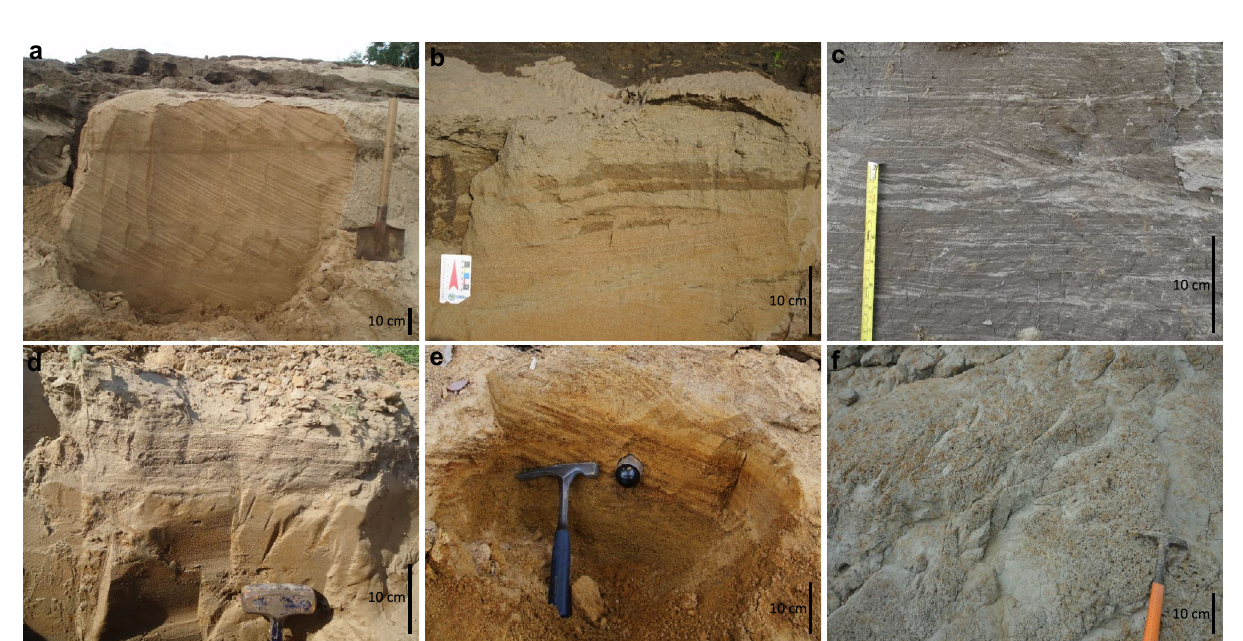
Fig. 5 | Major sedimentary facies representing deposits of the seasonally fl oo- ded environments. a Sets of fi ne sand with tabular cross strati fi cation (Amazon River near the Madeira River mouth). b Fine sand with tabular cross strati fi cation underlying fi ne sand layer with low-angle strati fi cation and cross lamination (Soli- mões River near the Negro River mouth). c Sandy mud with ripple and horizontal